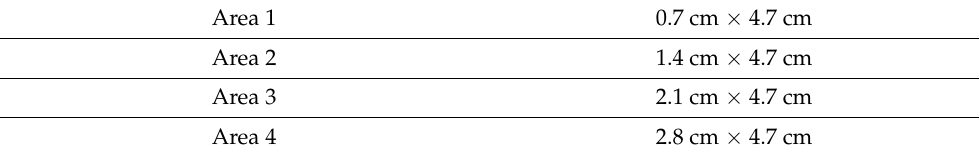
Table 2. Summary of the size configurations and the name of the size configurations.